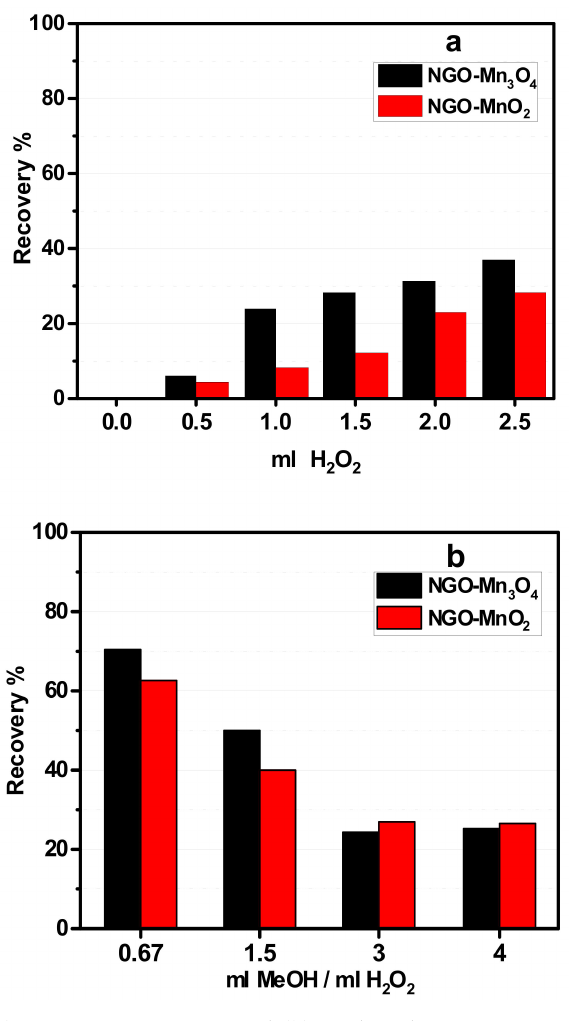
Figure 7. E ff ect of ( a ) H 2 O 2 concentration and ( b ) methanol / H 2 O 2 ratio on RB5 degradation by